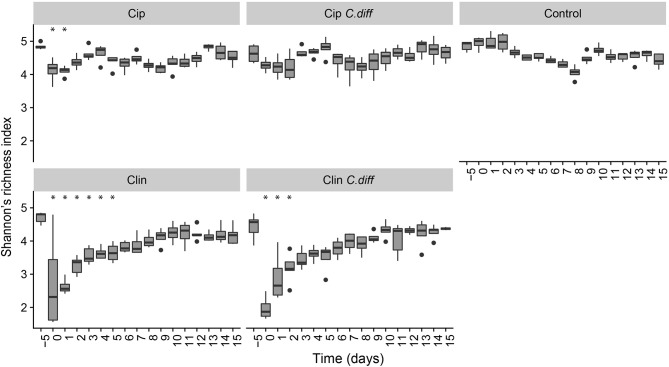
Recovery of bacterial diversity following antibiotic administration. Diversity is displayed as Shannon's H. For each treatment, asterisks represent time points which were significantly different from day −5 microbiomes (pairwise comparisons of a one way ANOVA using Tukeys's HSD, p < 0.01). Error bars represent standard error.